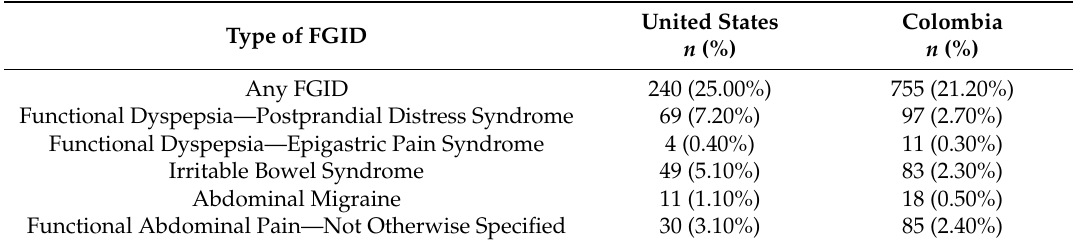
Table 2. Prevalence of functional gastrointestinal disorders (FGIDs) and functional abdominal pain disorders in children from United States and Colombia using the Rome IV classification